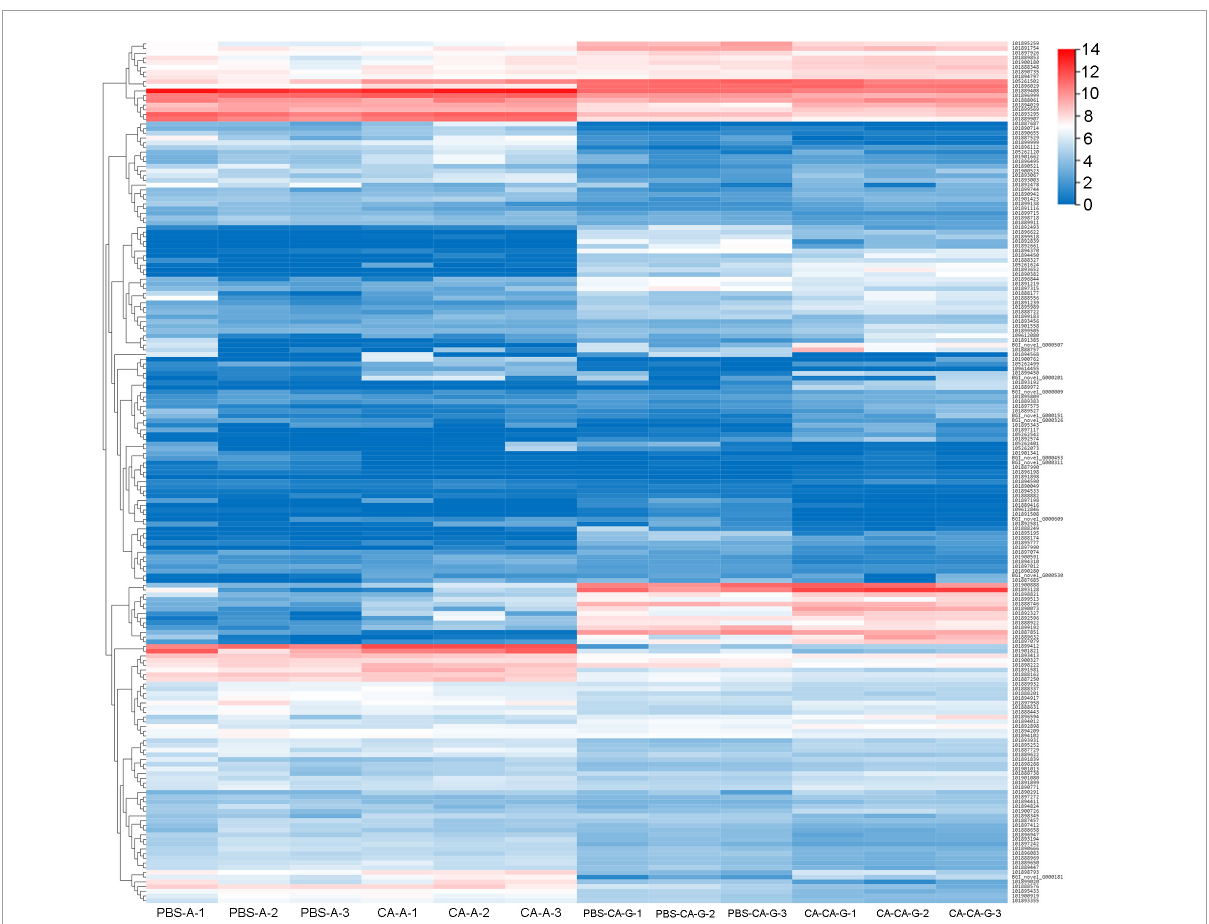
FIGURE6 Clusters of the differentially expressed genes. Heat map shows expression kinetics of the 183 transcripts of housefly adults primed with C. albicans or injected with PBS as control and offspring larvae challenged with a lethal dose of C. albicans . The color scale indicates the expression level of the